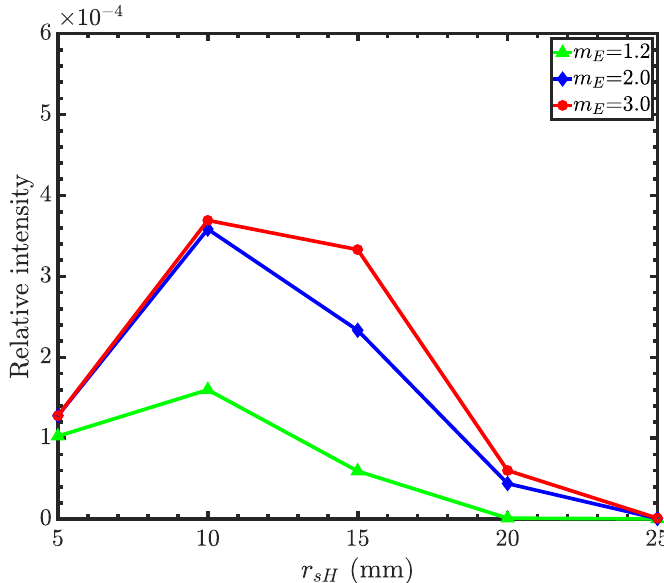
Figure 12. Relative intensity for a Wolter III microscope as a function of hyperboloid mirror front-edge radius with different ellipsoid mirror coatings. The hyperboloid mirror coating is